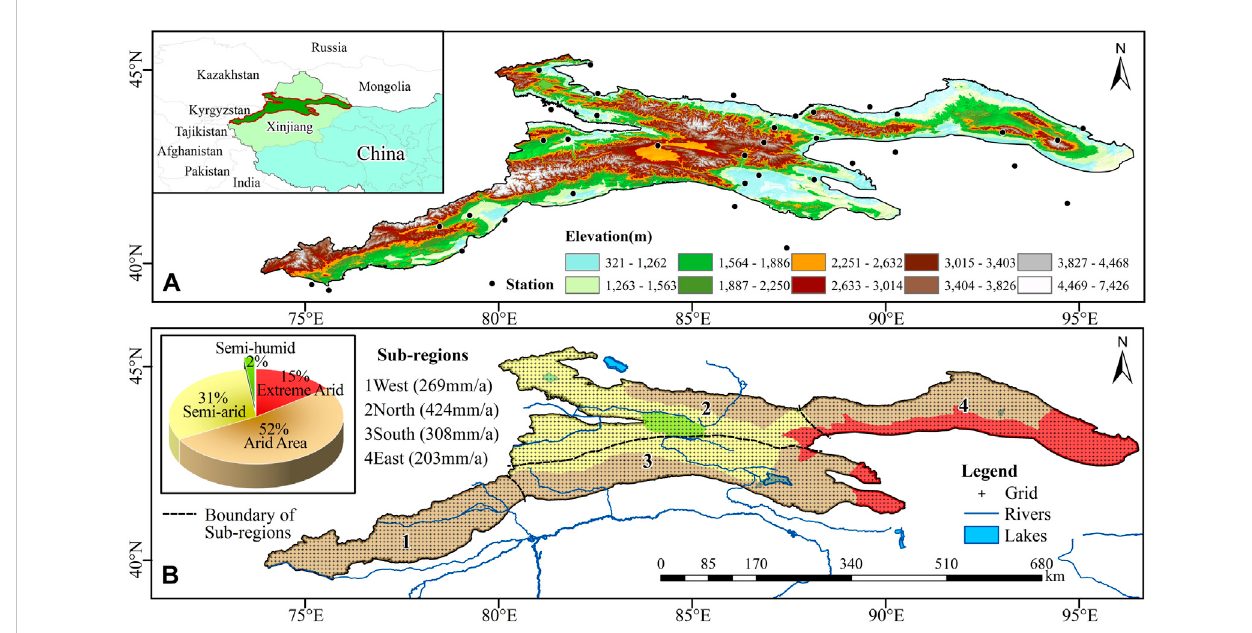
FIGURE 1 (A) Geographical location, topography and distribution of meteorological stations in the Tianshan Mountains; (B) Zoning boundary and drought conditions in the Tianshan